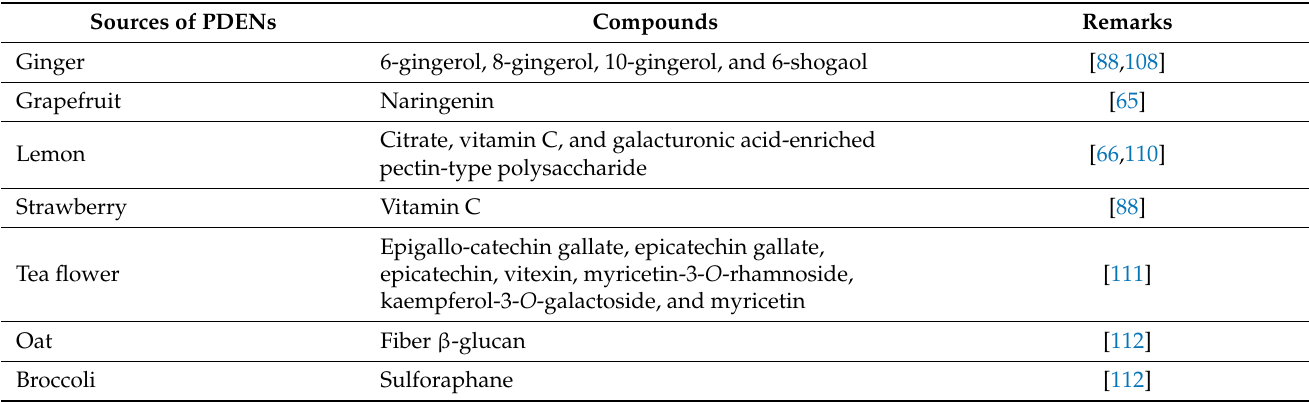
Table 1. Metabolites found in PDENs from several